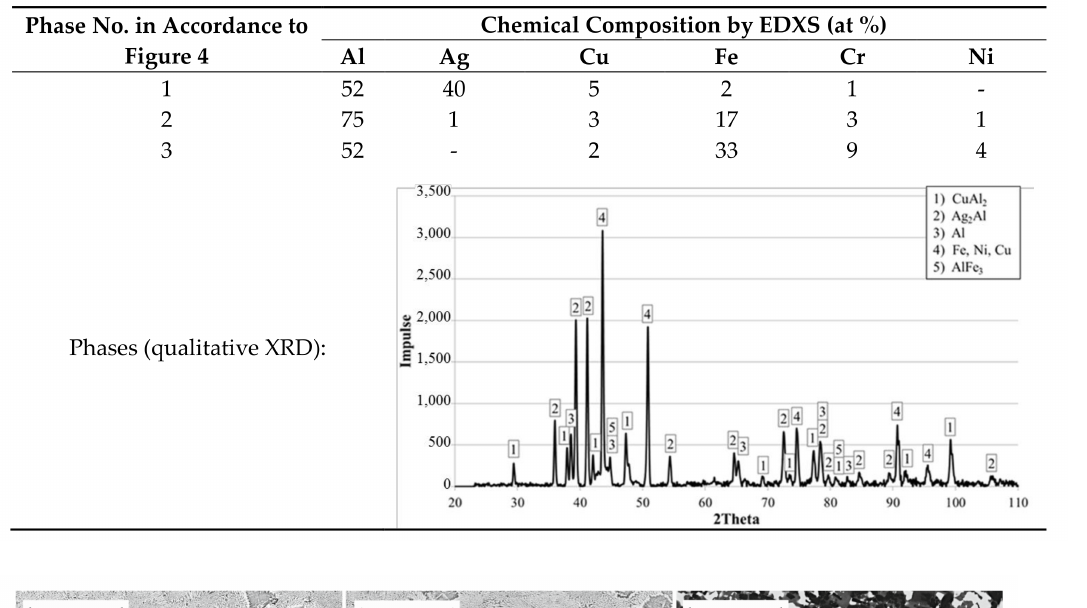
Table 3. Chemical compositions (EDXS) of phases and detected phases (XRD) in braze filler